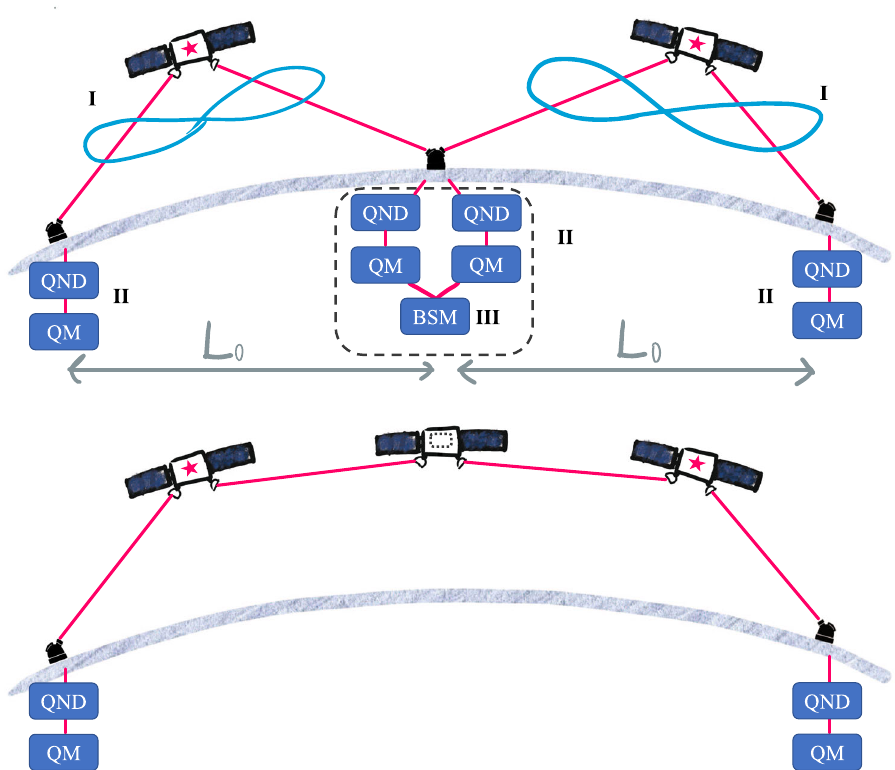
Fig. 1 Comparison of hybrid and fully space-based quantum repeater architectures. Top: Hybrid QND-QR protocol, following 37 with nesting level, n = 1 and segment length, L 0 . Entangled photon pairs are created by on-board sources (red stars) and sent to ground stations (I). After a QND detection heralds the arrival of the photons they are loaded to QMs (II). BSM is performed between the memories to extend entanglement between end stations (III). Bottom: New architecture where the QND and QMs are also located on-board an orbiting